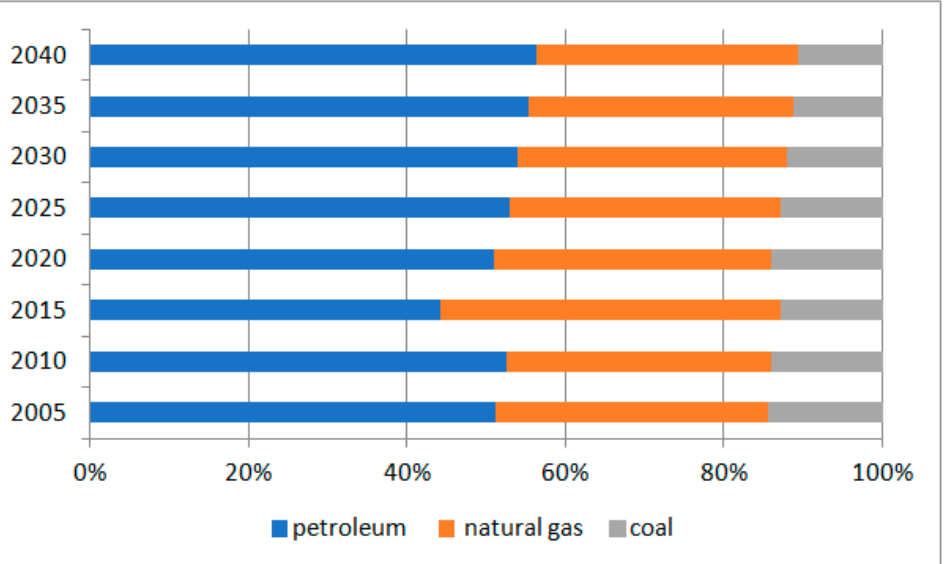
Figure 22. Forecast of fuel prices in imports to the EU [69].